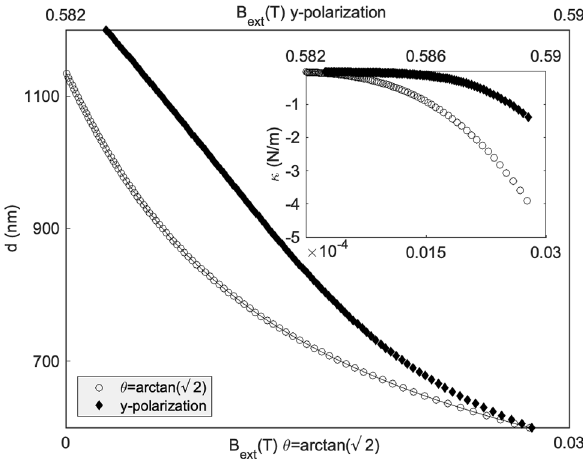
Figure 5. Equilibrium binding distance versus external magnetic field applied for 200 nm radii InSb particles illuminated with a plane wave of wavelength (cid:31) = 47.97 µ m, for y -polarization and polarization angle arctan ( √ 2 ) . Continuous line is the analytic approximation (19) while white points correspond to exact θ = numeric calculation. The inset shows the value of the spring constants at the different equilibrium points for incident beam intensity of 25 µ W / nm 2